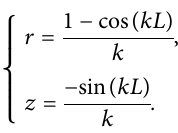
Frontiers in Robotics and AI |